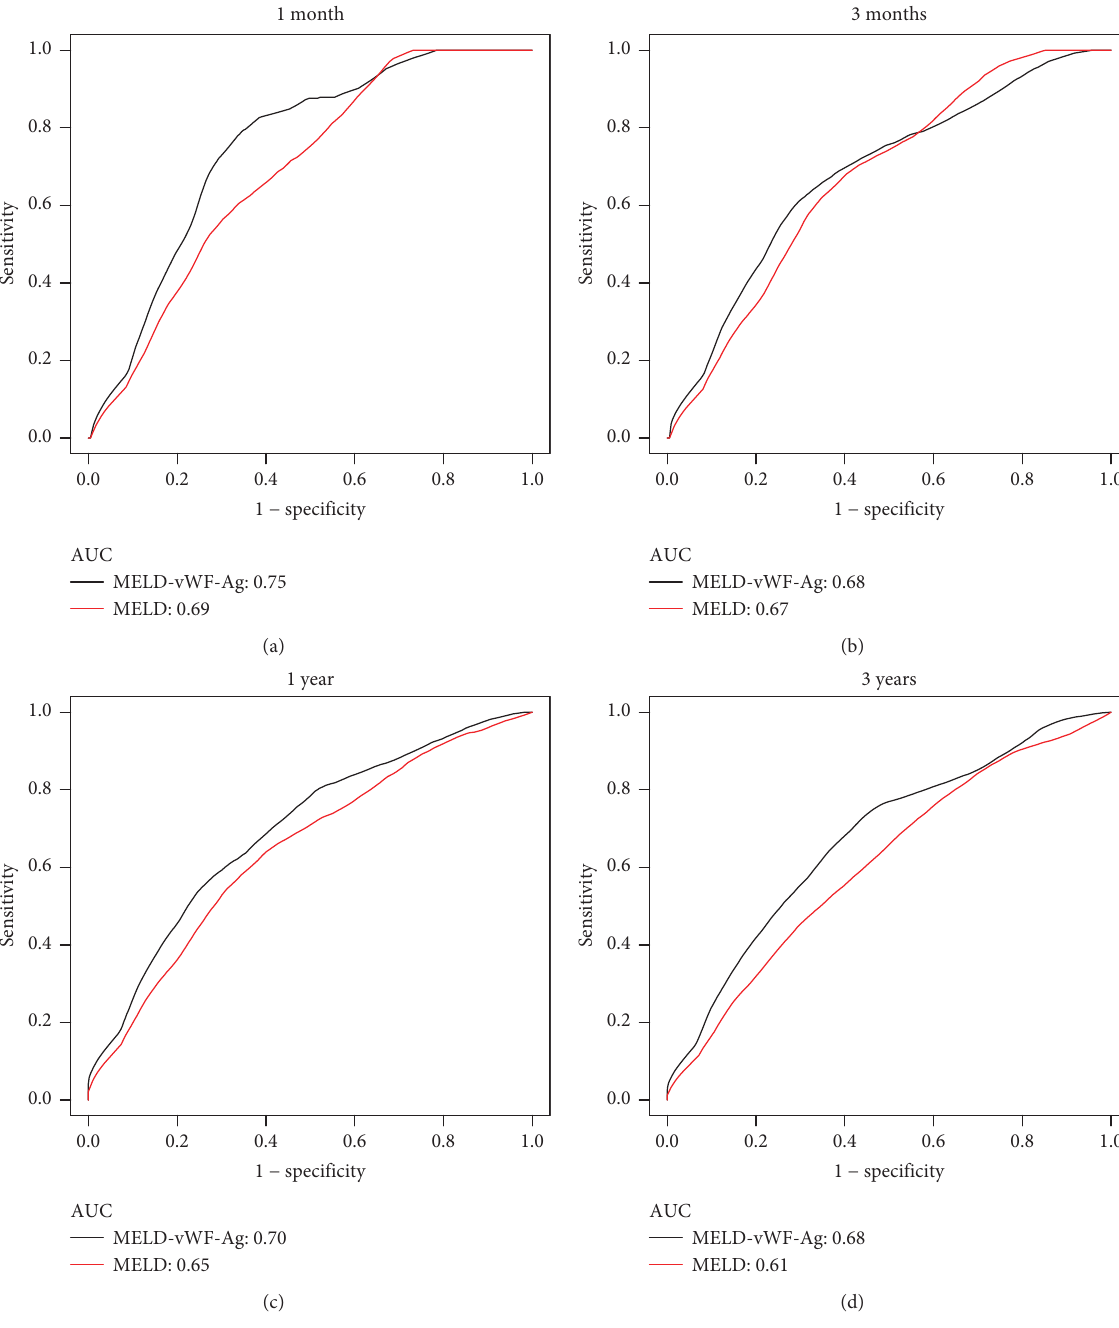
Figure 5: Time-dependent receiver operating characteristic (ROC) of MELD and MELD-vWF-Ag at 1 month, 3 months, 1 year, and 3 years for transplant-free mortality. (a) AUC of MELD and MELD-vWF-Ag at 1 month for transplant-free mortality; (b) AUC of MELD and MELD-vWF-Ag at 3 month for transplant-free mortality; (c) AUC of MELD and MELD-vWF-Ag at 1 year for transplant-free mortality; (d) AUC of MELD and MELD-vWF-Ag at 3 year for transplant-free